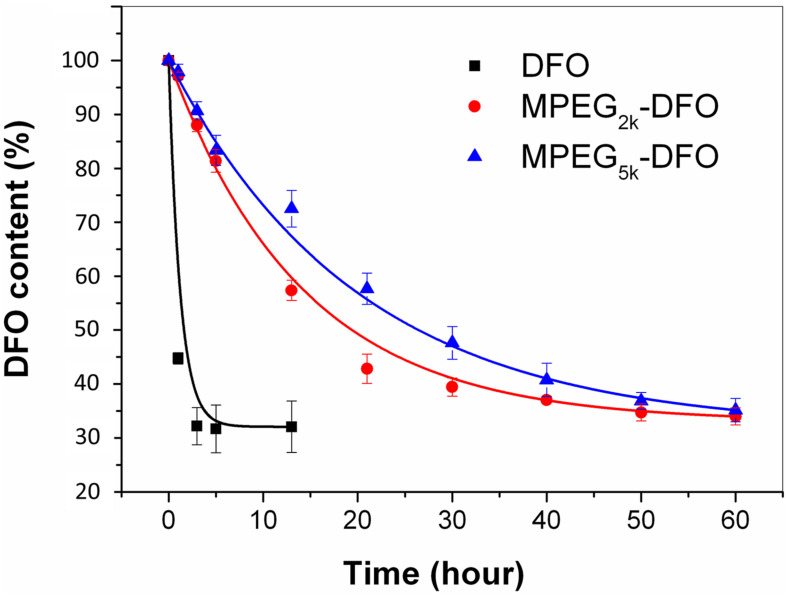
Metabolism assay for the PEGylated DFO.